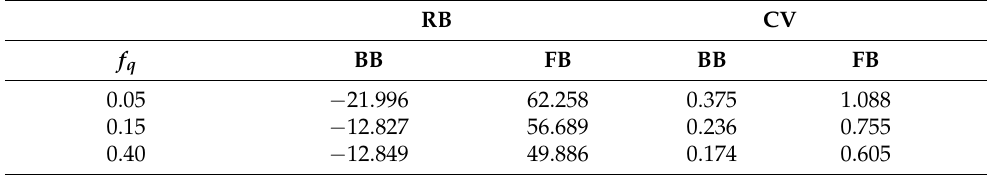
Table 4. Performance indicators for DGP 2 with p = 0.4.